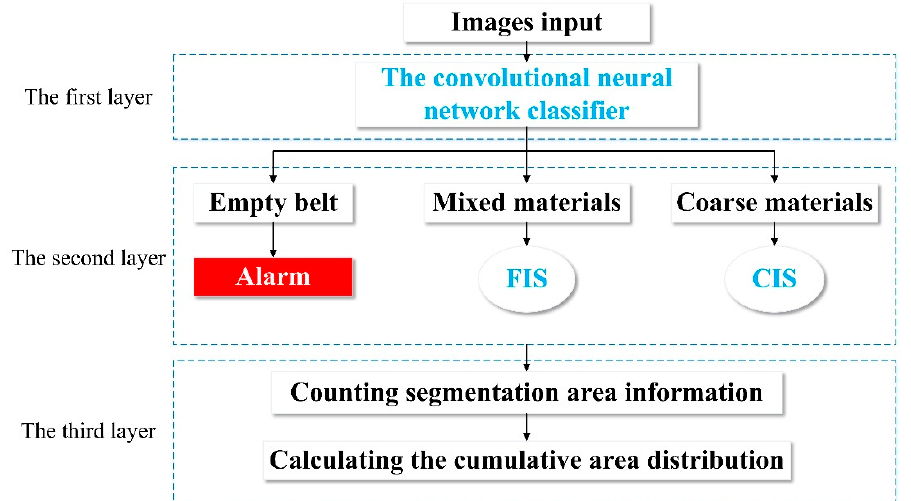
Figure 1. The technical roadmap of the method.